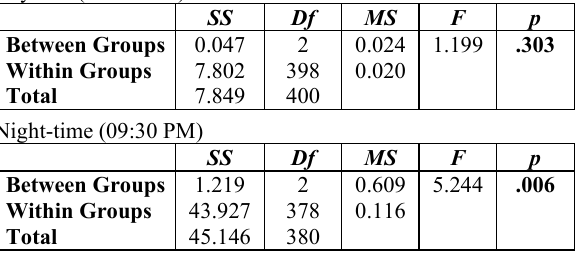
Table 4. ANOVA summary for daytime and night-time, where SS is the sum of squares, df is the degree of freedom, MS is the mean square, F is the F-statistics, and p is the probability value In particular, results show that at night, we can reject the null hypothesis, and that the three classes of ventilation corridors